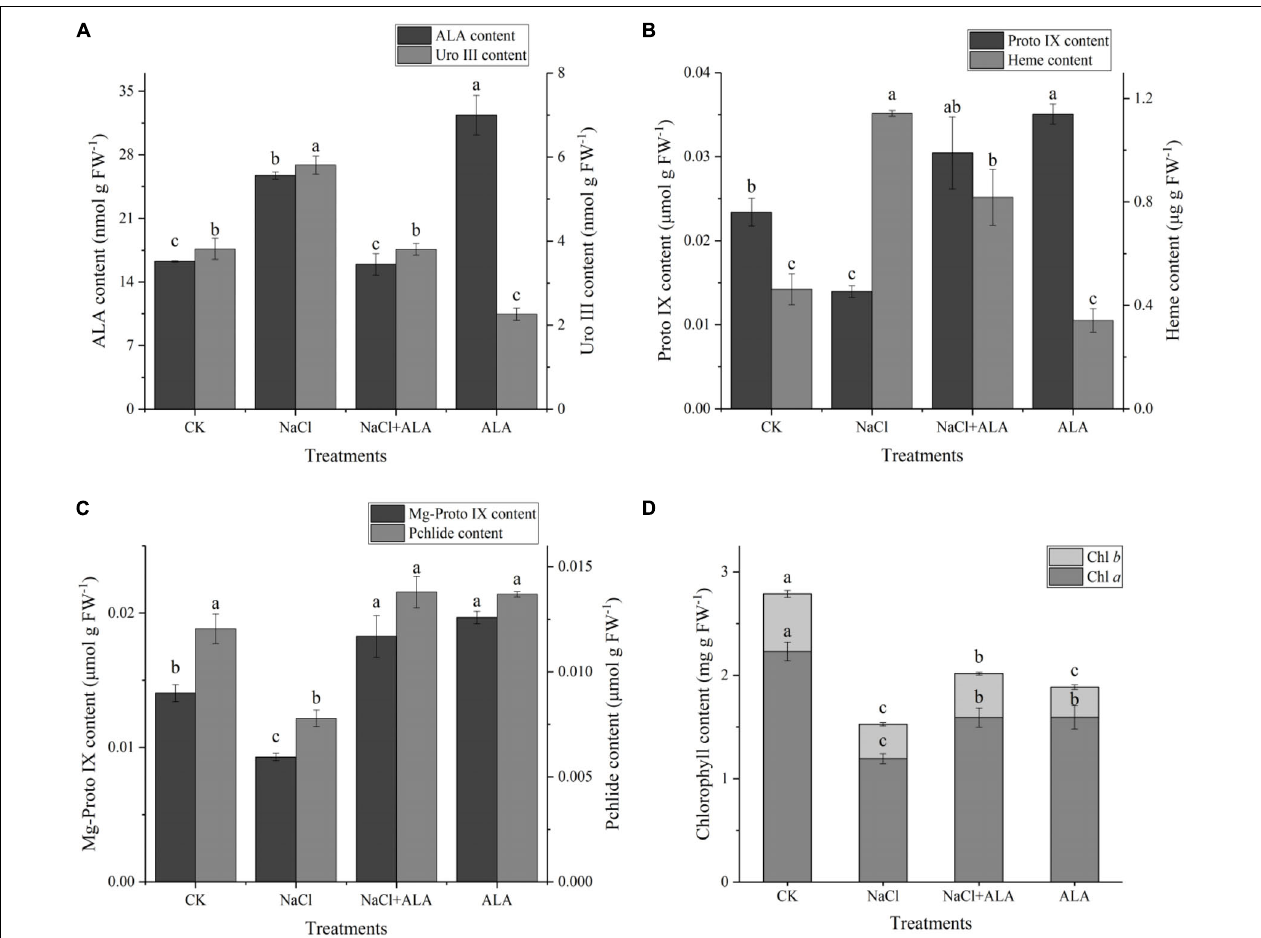
FIGURE 5 | Contents of intermediates on ALA metabolic pathway. (A) Contents of ALA (5-aminolevulinic acid) and Uro III (uroporphyrinogen III). (B) Contents of Proto IX (protoporphyrin IX) and heme. (C) Contents of Mg-Proto IX (Mg-protoporphyrin IX) and Pchlide (protochlorophyllide). (D) Content of chlorophyll, including Chl a and Chl b . The data presented were the means of 3 plants ± SE of means ( n = 3). Treatment means with different letters indicate significant differences according to Tukey’s test ( p <